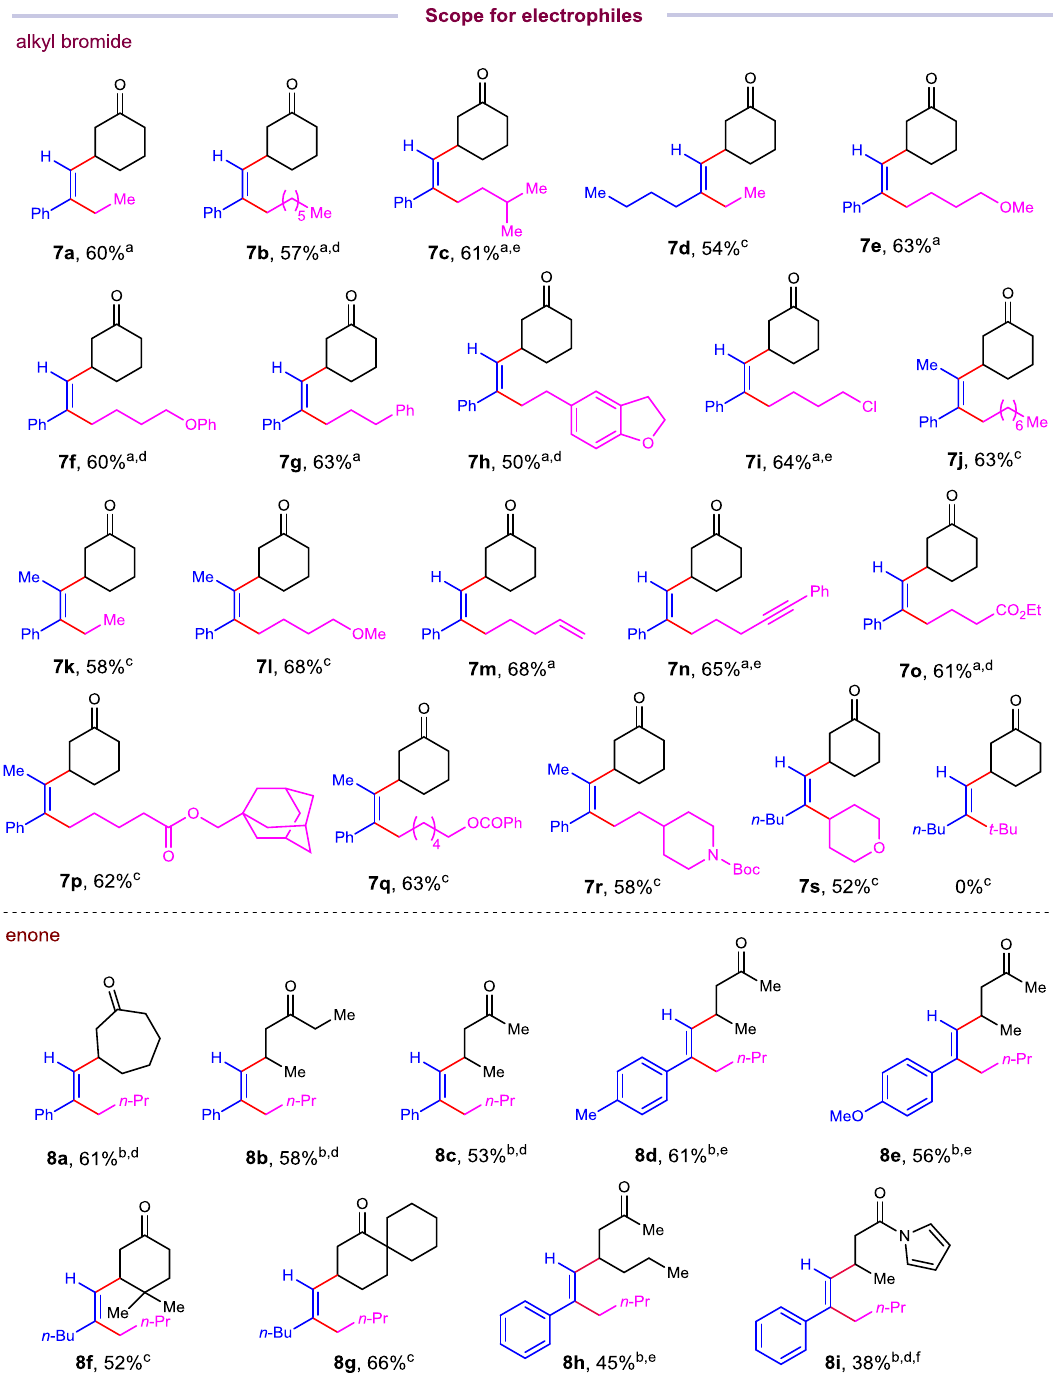
Fig. 3 Scope for the syn -cross-electrophile dialkylation of alkynes with respect to alkyl eletrophiles. Unless otherwise noted, isolated yield is shown on 0.2 mmol scale under standard conditions. See Table 1, entry 1 for detail. a NiBr 2 ·DME (10 mol%), A2 (20 mol%), Zn (2.5 equiv), KI (2.0 equiv), ZnBr 2 (10 mol%), 2-methyl-2-butanol (2.0 equiv), DMF (0.1 M), rt, overnight. b The reaction was conducted using 0.2 mmol of enone (1.0 equiv), alkyne (2.8 equiv), n -BuBr (3.5 equiv) in the presence of NiBr 2 ·DME (10 mol%), Zn (3.0 equiv), CsI (5.0 equiv), 2-methyl-2-butanol (2.0 equiv), and ZnI 2 (30 mol%) in DMF (0.05 M). c Standard conditions were used. d Alkyne was added in two potions. 1.0 equiv of alkyne was added after 5 h. e Alkyne was added in two portions. 1.0 equiv of alkyne was added after 3 h. f Yield based on the recovery of